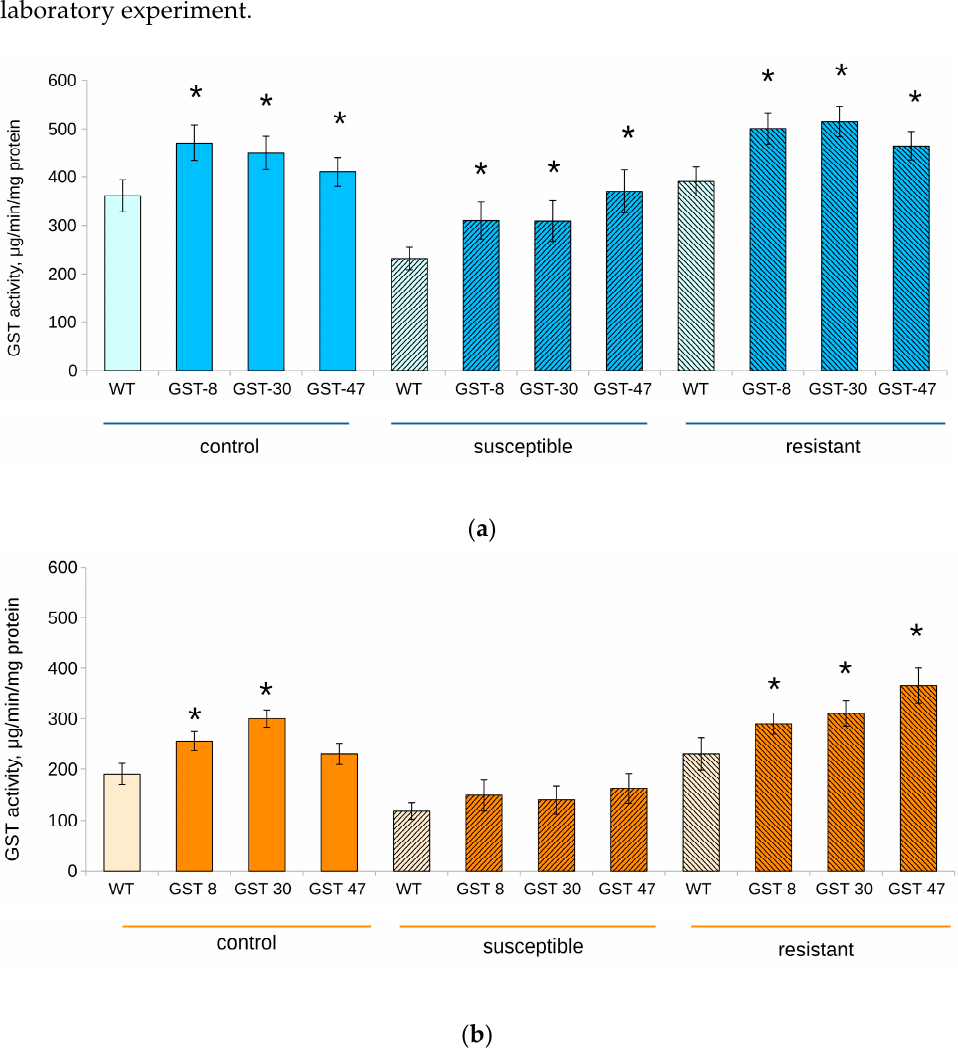
Figure 5. GST activity in transgenic (GST, lines 8, 30 and 47) and WT B. napus , exposed to powdery mildew infection. ( a ) Expe rimental plot ; ( b ) L aboratory. Asterisk (*) indicates a significant difference between WT and transgenic plants from the same group.